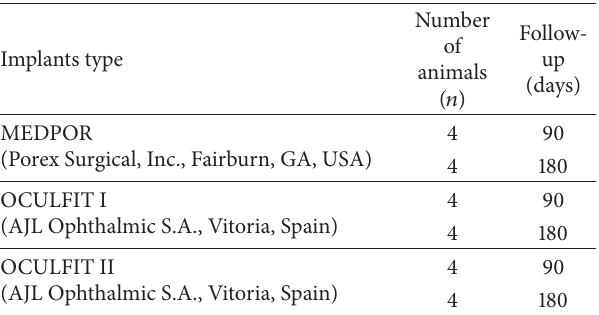
Table 1: Animal distribution and follow-up time for each orbital implant